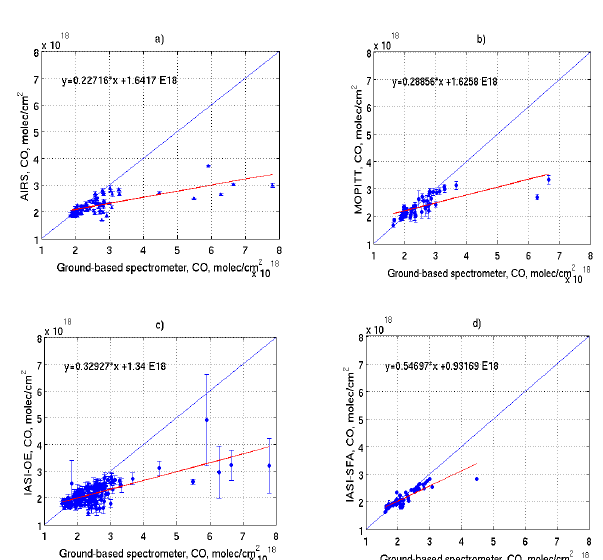
Fig. 4. Scattergrams of CO TC for 3 sounders compared to ground data over Zvenigorod for matching days between January 2009 and September 2010: (a) AIRS; (b) MOPITT; (c) IASI-OE; (d) IASI-